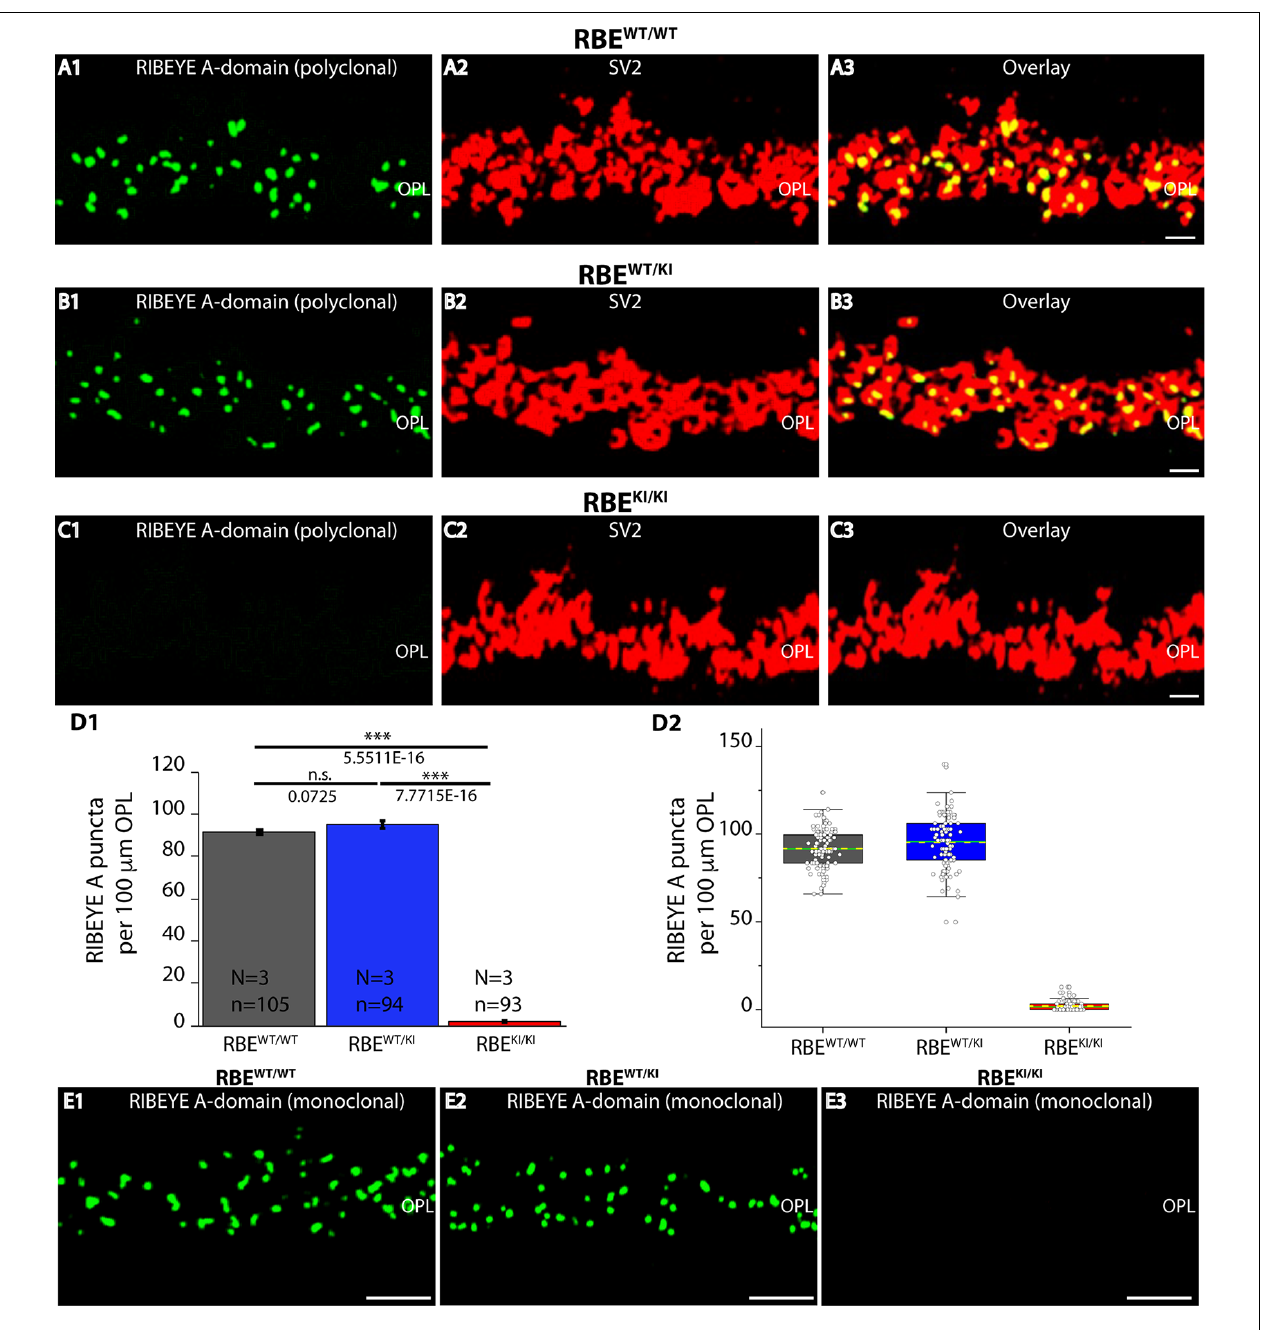
FIGURE 6 | Quantification of RIBEYE A-domain puncta in the OPL of RBE WT/WT , RBE WT/KI , and RBE KI/KI mice. (A1–A3,B1–B3,C1–C3) 0.5 µ m-thin retina sections of RBE WT/WT , RBE WT/KI , RBE KI/KI mice were double-immunolabeled with mouse monoclonal anti-SV2 and rabbit polyclonal antibody against RIBEYE A-domain (tau; Maxeiner et al., 2016). The OPL was analyzed at high magnification to determine RIBEYE A-domain puncta number/density in the OPL. (D1,D2) Quantification of RIBEYE A-domain puncta in OPL in (D1,D2) demonstrates that the number of RIBEYE A-domain puncta is unchanged between RBE WT/WT and RBE WT/KI . RIBEYE B-domain puncta were completely absent in the OPL of RBE KI/KI mice. The bar graphs in (D1) show means ± S.E.M (n.s., p > 0.05; ∗∗∗ p ≤ 0.001). In the box and whisker plots (D2) of the data from (D1) , means values are shown as horizontal yellow dotted line and median values by horizontal green solid line. The boxes represent the 25th-75th percentiles and whiskers represent 1.5 times IQR. The statistical analysis was performed by Student’s t -test for RBE WT/WT /RBE WT/KI comparison because data were normally distributed. Kolmogorov-Smirnov tests were used for RBE WT/WT /RBE KI/KI and RBE WT/KI / RBE KI/KI comparisons because RBE KI/KI data were non-normally distributed. (E1–E3) 0.5 µ m-thin retina sections of RBE WT/WT , RBE WT/KI , and RBE KI/KI mice were single-immunolabeled with mouse monoclonal antibody against RIBEYE A-domain clone 6F4. The two RIBEYE A-domain antibodies (monoclonal 6F4, polyclonal tau) produced very similar immunolabeling patterns also at the higher magnifications shown in Figure 6 . Abbreviations: OPL, outer plexiform layer; RBE, RIBEYE; S.E.M., standard error of the mean; IQR, interquartile range; n.s., non significant; N = number of mice; n = number of analyzed confocal images. Scale bar: 5 µ m.